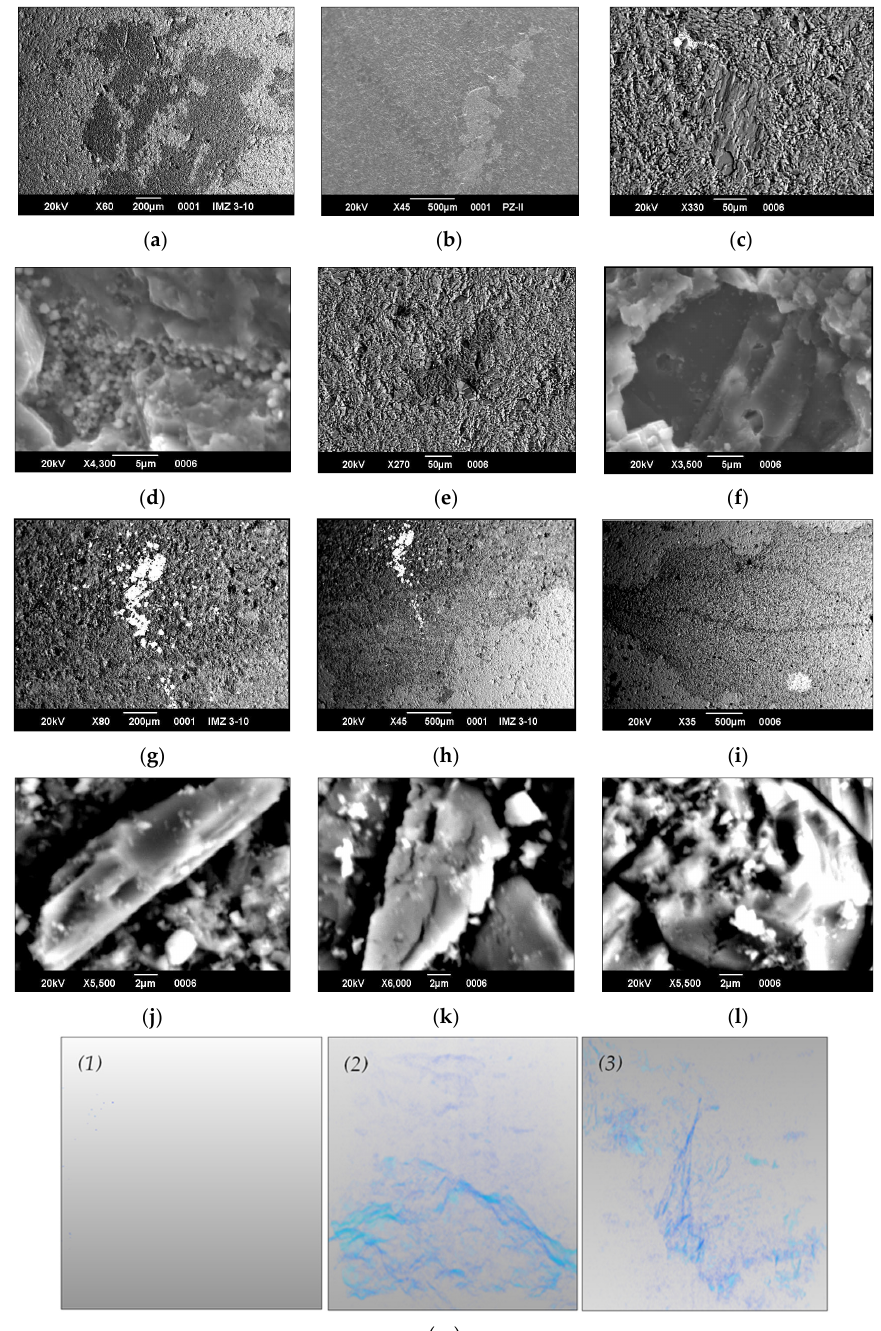
Figure 5. Scanning electron microscopic images and tomograms of organogenic limestone samples: ( a ) spotted distribution of dolomitisation zones (grey in the image) in “fresh” limestone samples from a borehole; ( b ) a sample of weathered limestone with a pyritisation zone (light); ( c ) sample of weathered limestone with pyrite in a cavity; ( d ) as previous, structural details; ( e ) sample of weathered limestone with micropores in calcite; ( f ) as previous, structural details; ( g ) silicified dolomite with pyrite in a weathered limestone sample; ( h ) junction of the silicification zone and calcite (light) in a weathered limestone sample; ( i ) development of dolomitisation zones (gray) in weathered limestone sample; ( j ) the deformation of a calcite crystal in a sample taken from mime outcrop; ( k,l ) deformation of a calcite crystal in limestone samples subjected to 1000 cycles of freezing and thawing under laboratory conditions; ( m ) sections of tomograms of organogenic limestone samples (sample size 4.0 cm × 4.0 cm × 4.0 cm): (1)—tomogram of the “fresh” sample, (2)—tomogram of the same sample after 1000 cycles of freezing and thawing under laboratory conditions, (3)—tomogram of a weathered sample taken from the outcrop surface.